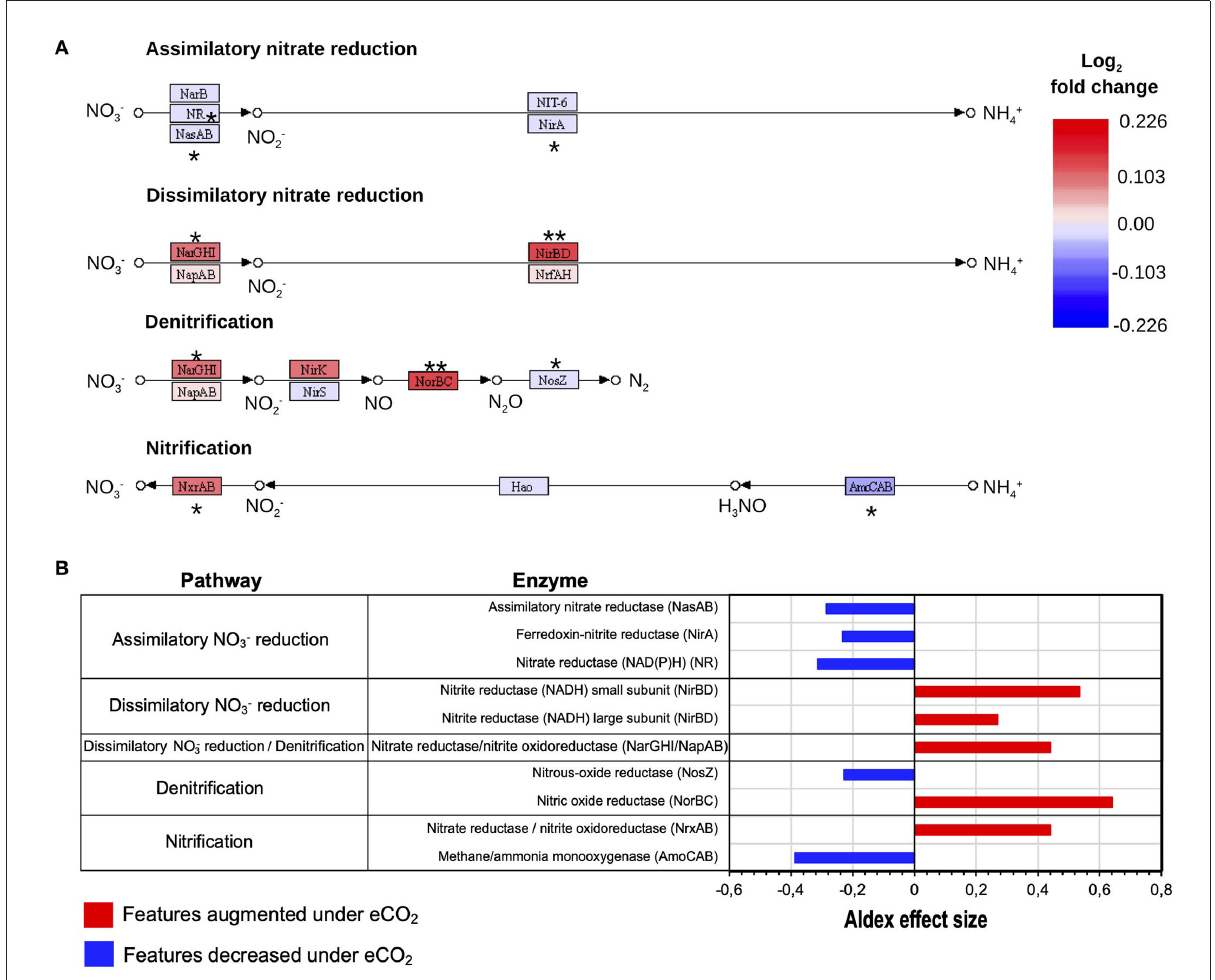
FIGURE4 Reconstructed KEGG (Kanehisa and Goto, 2000) N pathways of NO − 3 assimilatory and dissimilatory reduction, denitrification, and nitrification processes. (A) N transformations expressed as log 2 fold change of transcripts as relative abundance. ALDEx2 effect size: (**) > 0.5, (*) > 0.2. (B) Differential abundance of N cycle transcripts with ALDEx2 effect sizes >